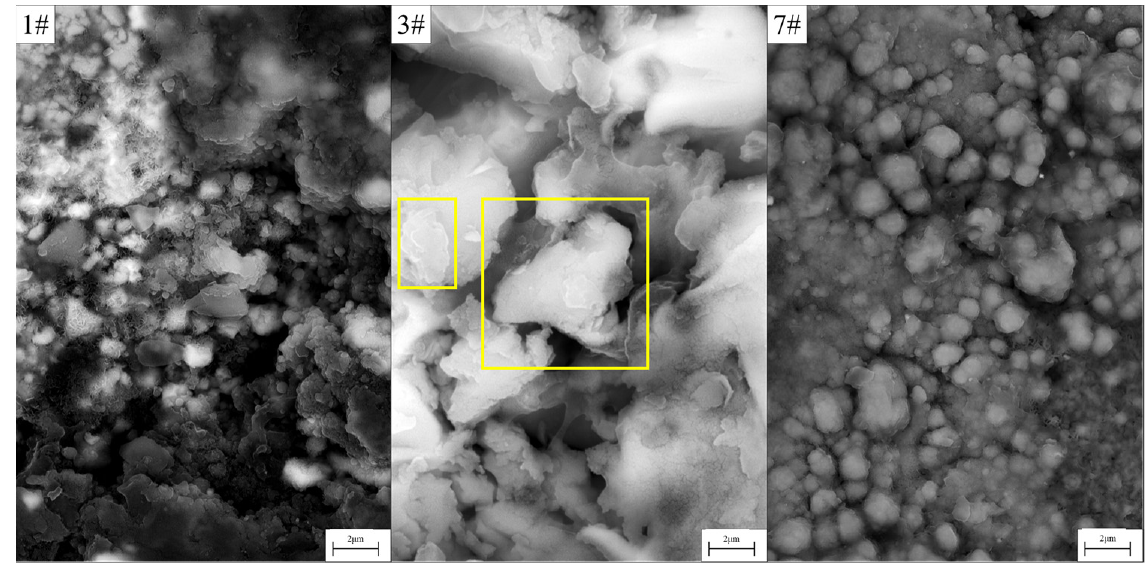
Figure 11. SEM images of the third reduction stage of iron oxides with different